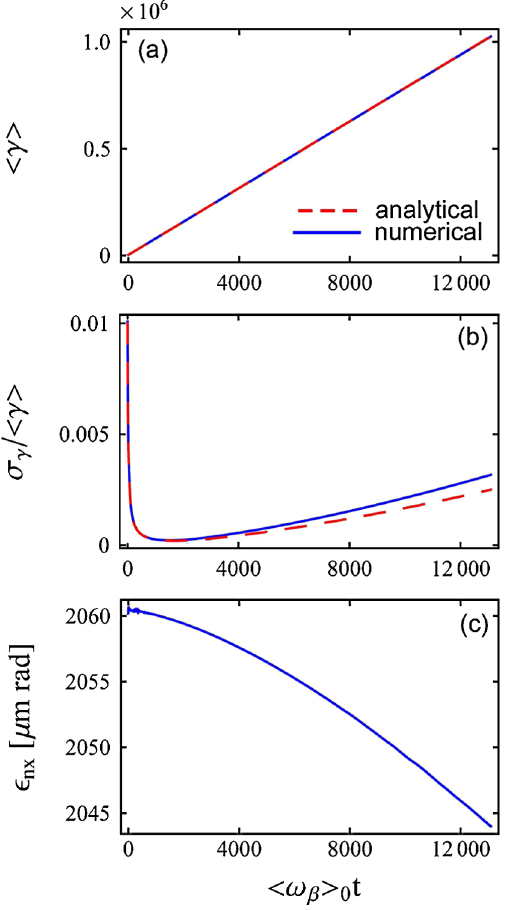
¼ FIG. 1. The beam dynamics over one stage for the n e 10 15 cm (cid:1) 3 case in Table I: (a) mean energy, (b) relative energy spread, and (c) normalized transverse emittance for an initially matched beam with an initial emittance of 2060 (cid:2) m rad injected ¼ 10 15 cm (cid:1) 3 ) with into a 333 m long, low density LPA stage ( n e initial energy 1 GeV, initial energy spread of 1%, and constant ¼ 1 : 5 GV = m . The blue curves represent our acceleration E z numerical calculations, while the red dashed curves correspond to the respective analytical expressions, Eqs. (26) and (27). The i t corresponds to the maximum propagation distance h ! (cid:8) 0 max stage